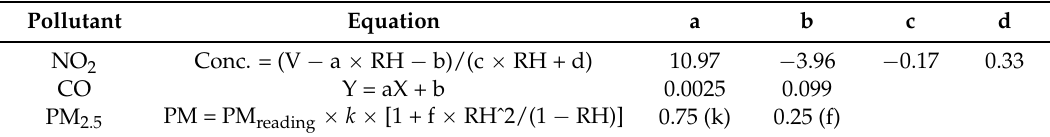
Table 3. Correction equation for MAS